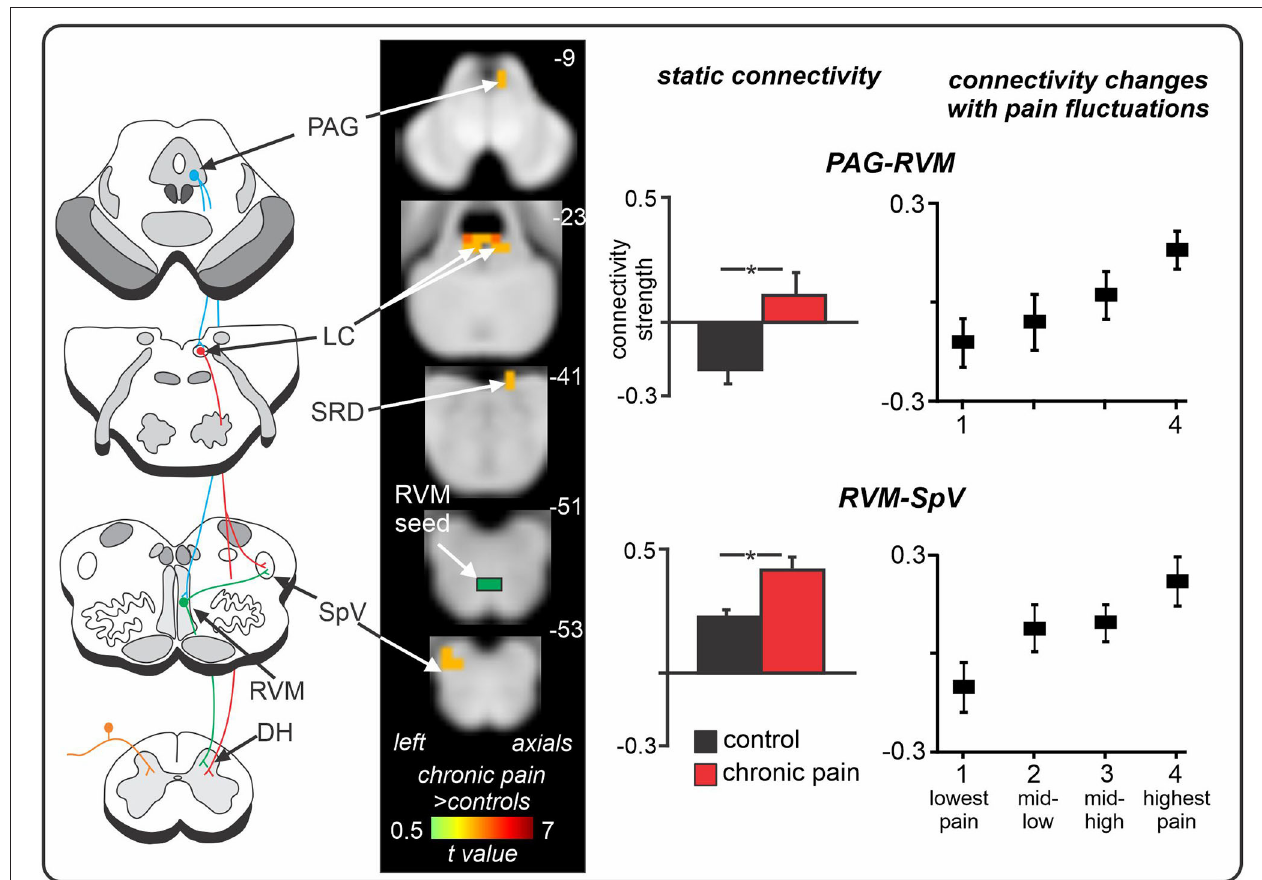
FIGURE 4 | Spontaneous changes in periaqueductal grey (PAG) - rostral ventromedial medulla (RVM) - spinal trigeminal nucleus (SpV) fMRI signal coupling in chronic neuropathic orofacial pain. Compared to controls, individuals with chronic pain show enhanced positive functional connectivity between the RVM “seed” and the PAG and SpV, in addition to the locus coeruleus (LC) and subnucleus reticularis dorsalis (SRD). Furthermore, in neuropathic pain patients, as the intensity of their clinical pain changes throughout a 12-min fMRI scan, so too do their RVM connectivity strengths with the PAG and SpV. That is, when pain intensity is spontaneously low, RVM connectivity strengths with both the PAG and SpV are low; and when pain intensity is spontaneously high, RVM connectivity strengths are high and positive. * significant between-groups difference determined in a voxel-by-voxel analysis. Figure modified with permission from ( 32) and Mills et al. Journal of Pain